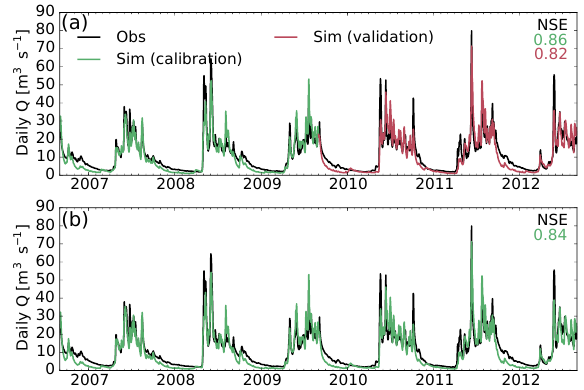
Figure 4. Simulated (green and red curves) and observed (black curve) daily discharge from the Atnsjoen catchment. (a) is showing the simulation results for 3 years of calibration (green) and 3 years of validation (red). (b) is showing the results for the 6-year calibra- tion period. Parameters estimated in the latter are used in the case study. Parameters not included in the optimization are set to mid estimate values during the calibration process (see Table 2).